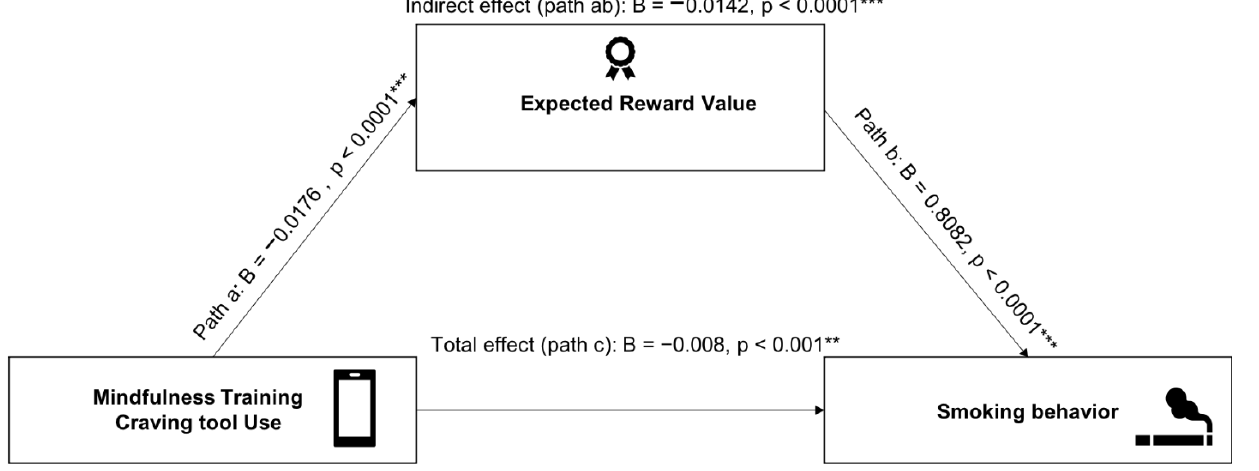
Figure 3. Mediation diagram for the impact of time (predictor) on smoking behavior using expected reward values as a mediator. ** p < 0.001, *** p < 0. 0001.